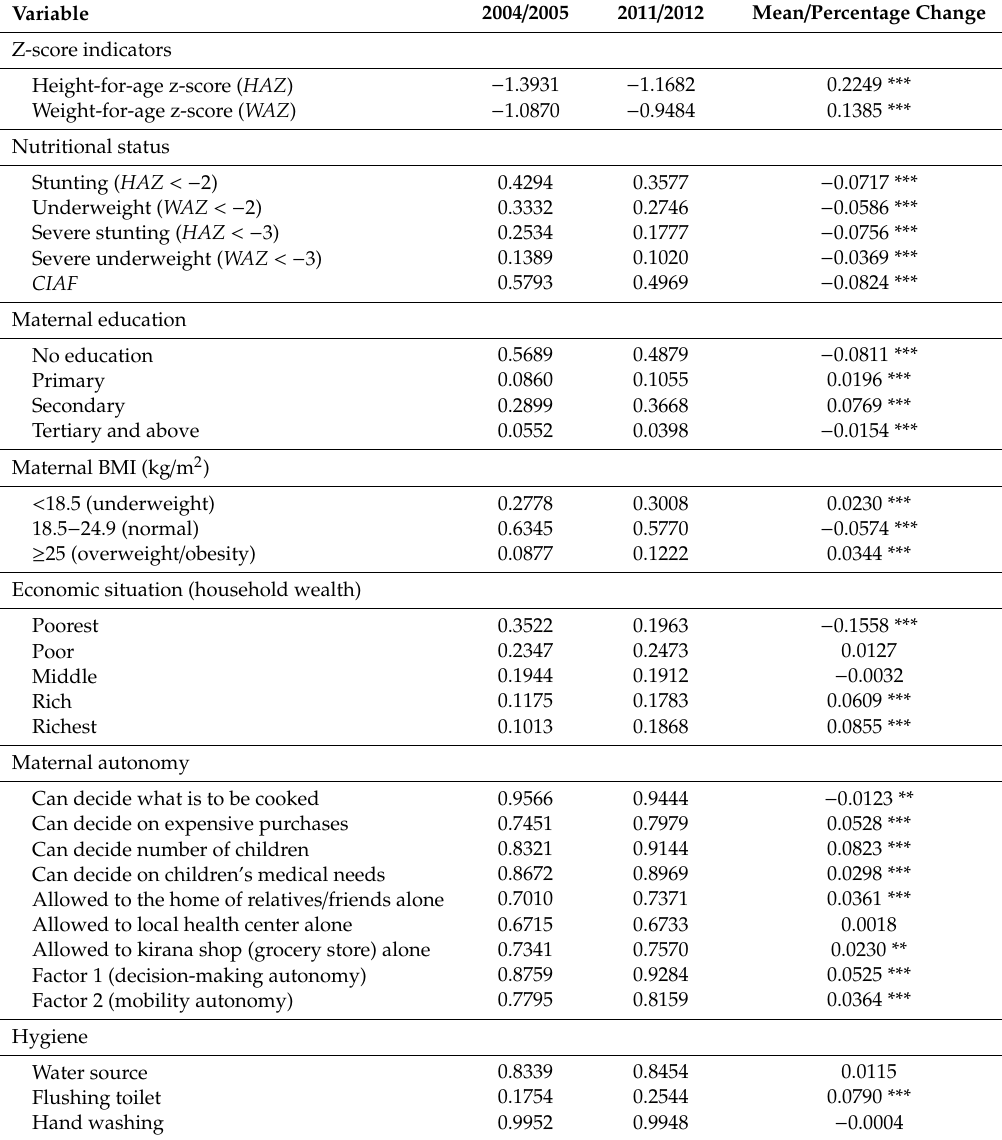
Table 1. Descriptive statistics of nutritional outcomes and covariates, IHDS 2004 / 2005–2011 /